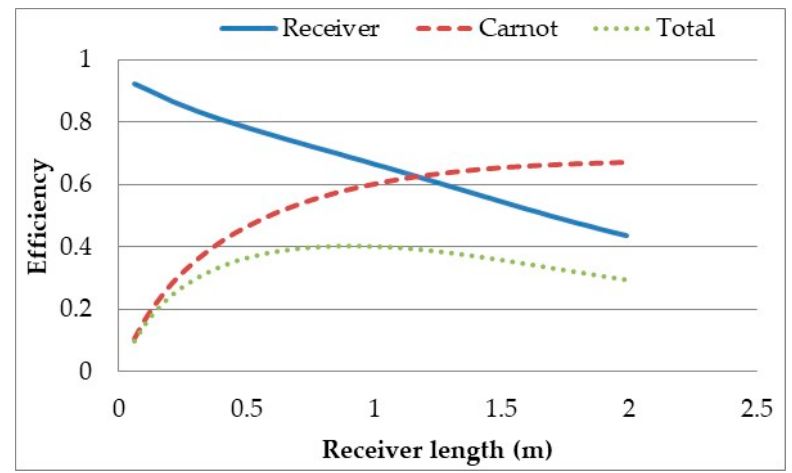
Figure 10. Overall power plant efficiency versus receiver length at high temperature: heat loss calculation applying linear heat loss coefficient.